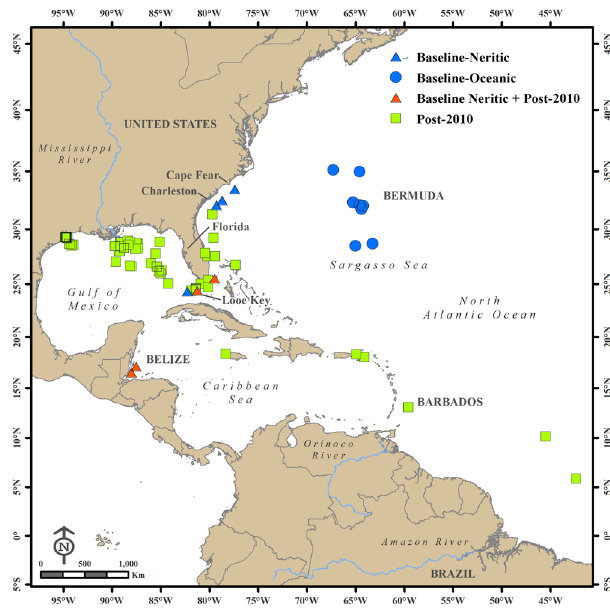
Fig. 1 Sargassum collection locations. Locations in the North Atlantic Ocean where Sargassum samples were collected during the 1980s baseline study 5 (blue), post-2010 collections (green), and during both time frames